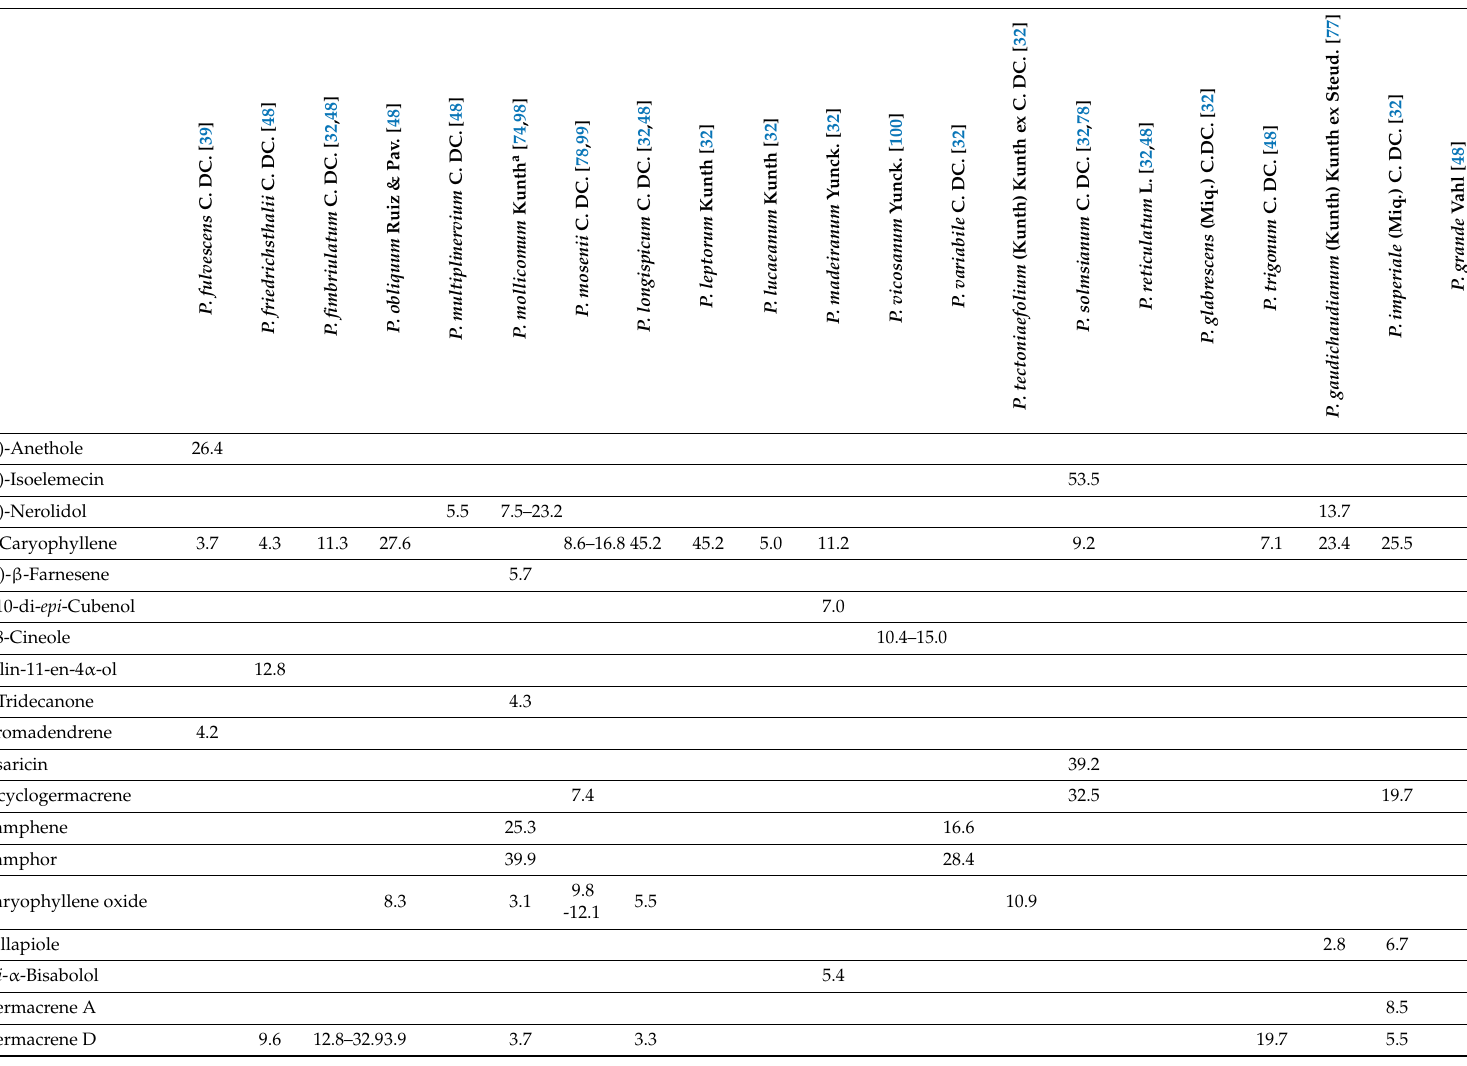
Table 24. Chemical compositions (%) of leaf essential oils from miscellaneous Piper species, part